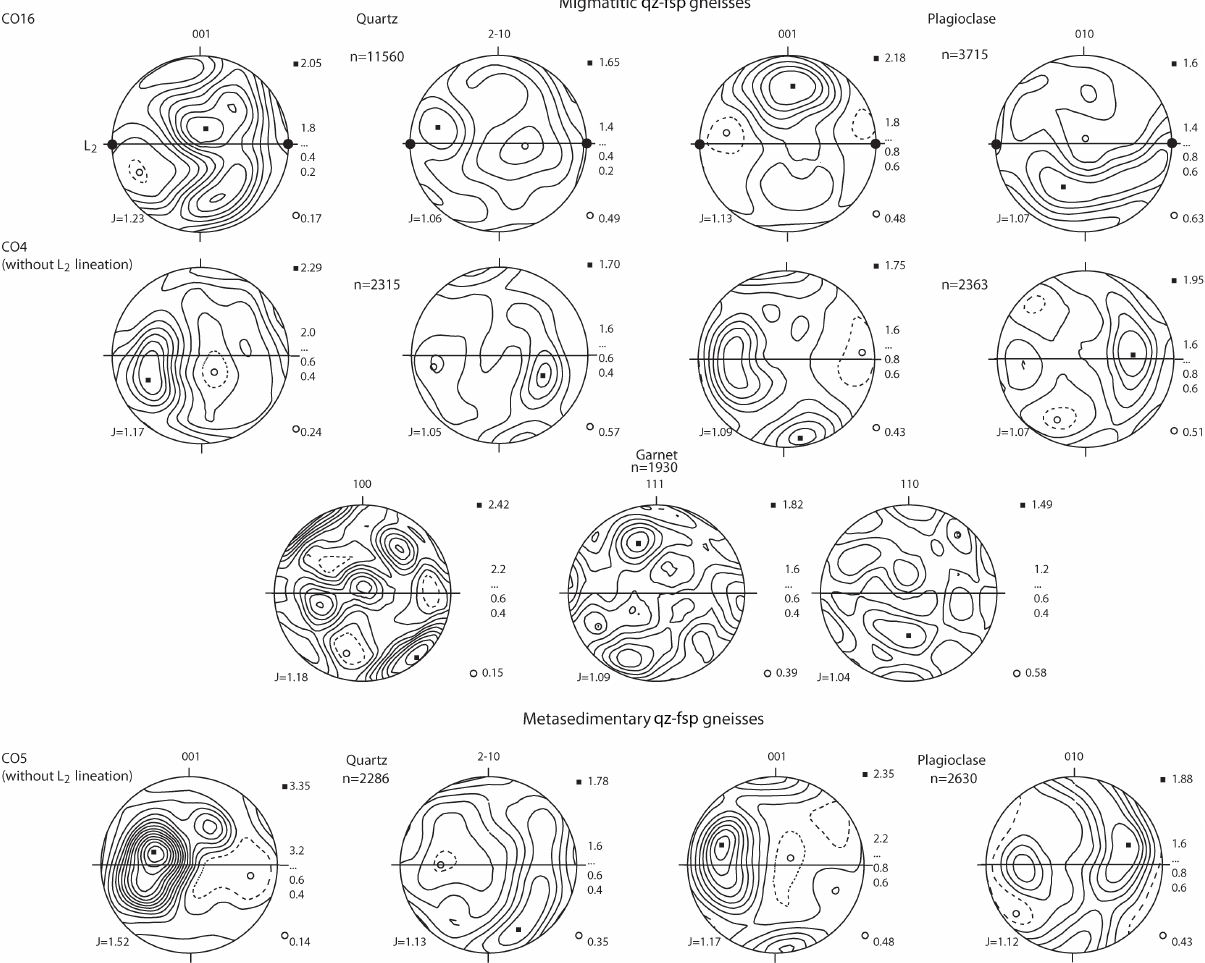
Figure 9. Crystallographic preferred orientation (CPO) patterns in quartz and plagioclase, in relation to the main S 2 foliation in the qz-fsp gneisses. Sample locations are in Fig. 2. Contouring is in multiples of uniform distribution (Gaussian half width 15). Items indicated in the stereo plots are the following: bottom left, the J -index; right, the values of contours. Equal area projection, lower hemisphere. S 2 foliation is plotted E–W vertical and the L 2 -lineation, if sufficiently developed, is plotted E–W horizontal. Crystallographic preferred orientation (CPO) pattern in garnet formed in the S 2 -tectonic fabric in sample CO 4 is also